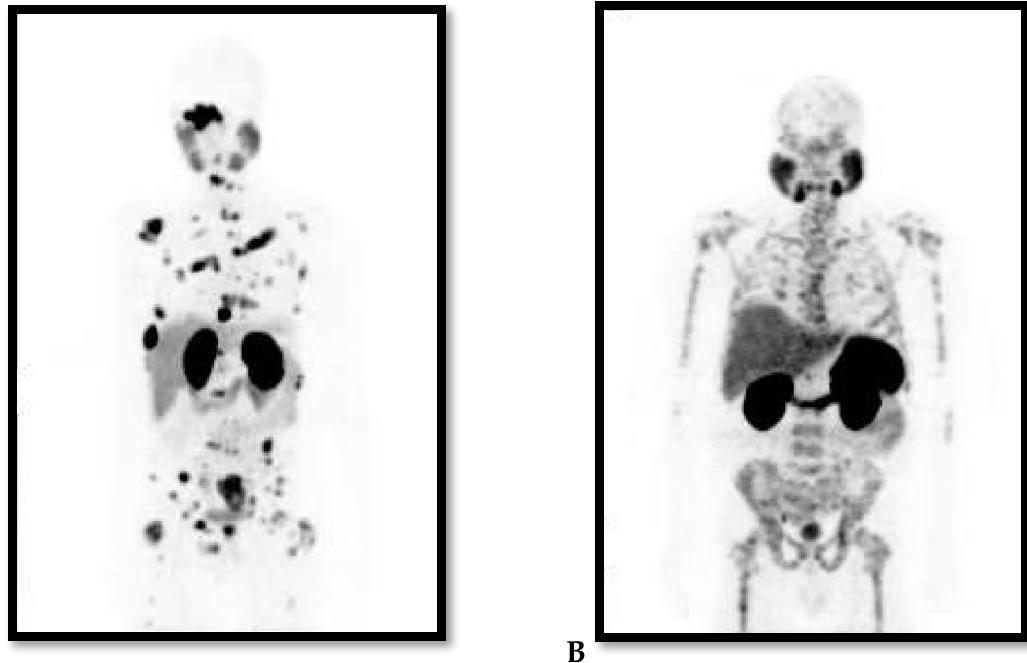
Figure 1. ( A and B Maximum Projection images): 68 Ga-PSMA PET images of two patients with advanced/metastatic prostate cancer to the skeleton. Note the difference in pattern of bone involvement and both are diffused skeletal demonstrating lytic and sclerotic. ( A ) demonstrates focal pattern but widespread lesions; ( B ) demonstrates lesions that are widespread in pattern interrupted with areas in the bone of no uptake within the affected